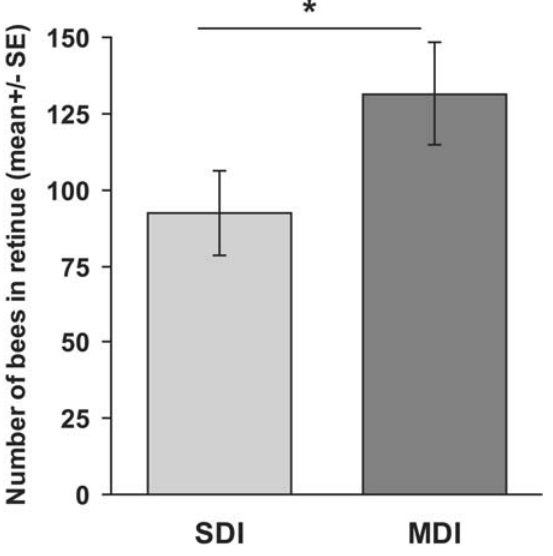
Figure 1. Workers are more attracted to MDI than SDI queens in observation hives. Following insemination, the retinue response to SDI and MDI queens was monitored in observation hives, twice a day for 5 days. MDI queens attracted significantly more worker bees in their retinue than the SDI queens did (F=6.73, p=0.02). (SDI: 7 queens; MDI: 5